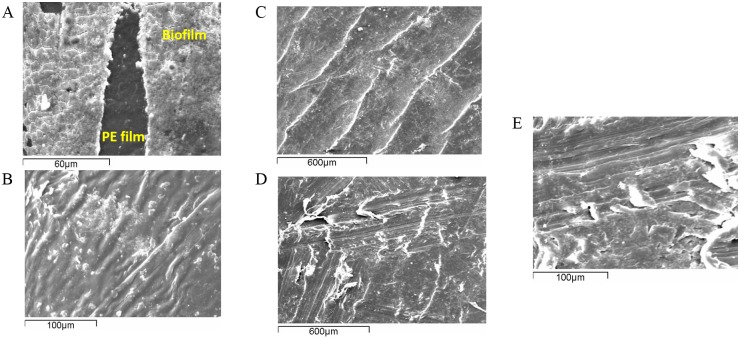
SEM analysis.SEM images of biofilm formed by the marine microbes on polyethylene: (A) at the end of first month, (B) at the end of the phase II and of the surface of the weathered pieces before (C) and after exposure to microbial treatment (D) & (E) at the end of phase II.